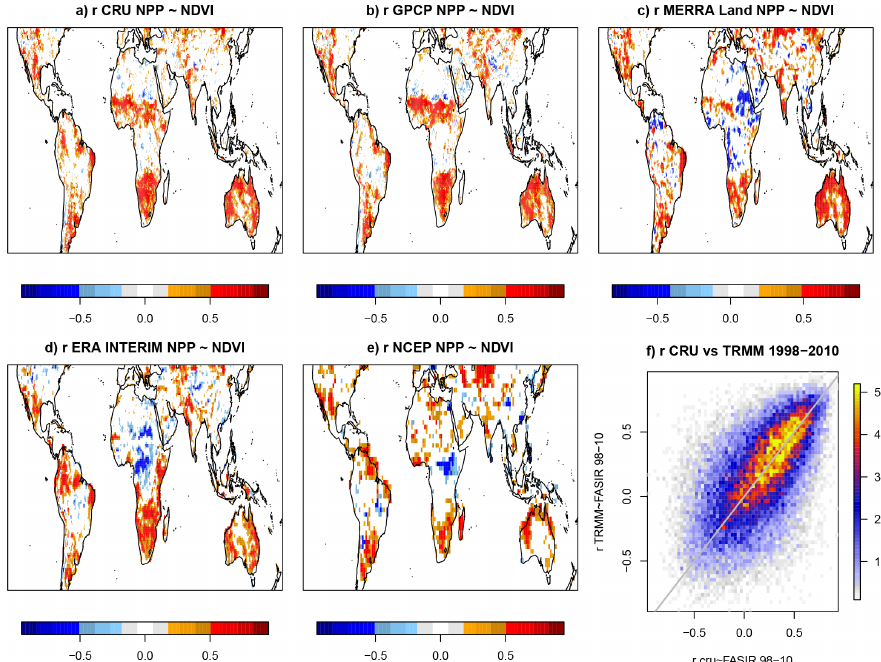
Figure 6. Spatial distributions of correlations (significant at p < 0 . 1) between NDVI time series and potential NPP time series calculated from annual precipitation amounts for 1982–2010 (2000 excluded). (a) Correlations for CRU data, (b) GPCP data, (c) MERRA Land reanalysis, (d) ERA Interim reanalysis and (e) NCEP/NCAR reanalysis. (f) Density scatter plot of correlations for the CRU and TRMM (version 3B43) data for the periods of 1998 and 2010 (all (significant and not significant) correlations included; grey line is the 1 : 1 line). The mean correlation for TRMM 3B43 data ( r = 0 . 188) was significantly higher ( p = 0 . 0033) than for CRU data ( r = 0 . 181). The mean temporal correlation for TRMM 3A12 data ( r = 0 . 115) between 40 ◦ S and 40 ◦ N was significantly lower (note: agreement between TRMM 3A12 and 3B43 was higher over oceans – not shown). All reanalysis products (c–e) show poor correlations for the Sahel and savanna regions south of the Sahara. Notice areas with negative correlations in the south-eastern parts of the Sahara in the CRU (a) and GPCP (b) data (see also Fig.